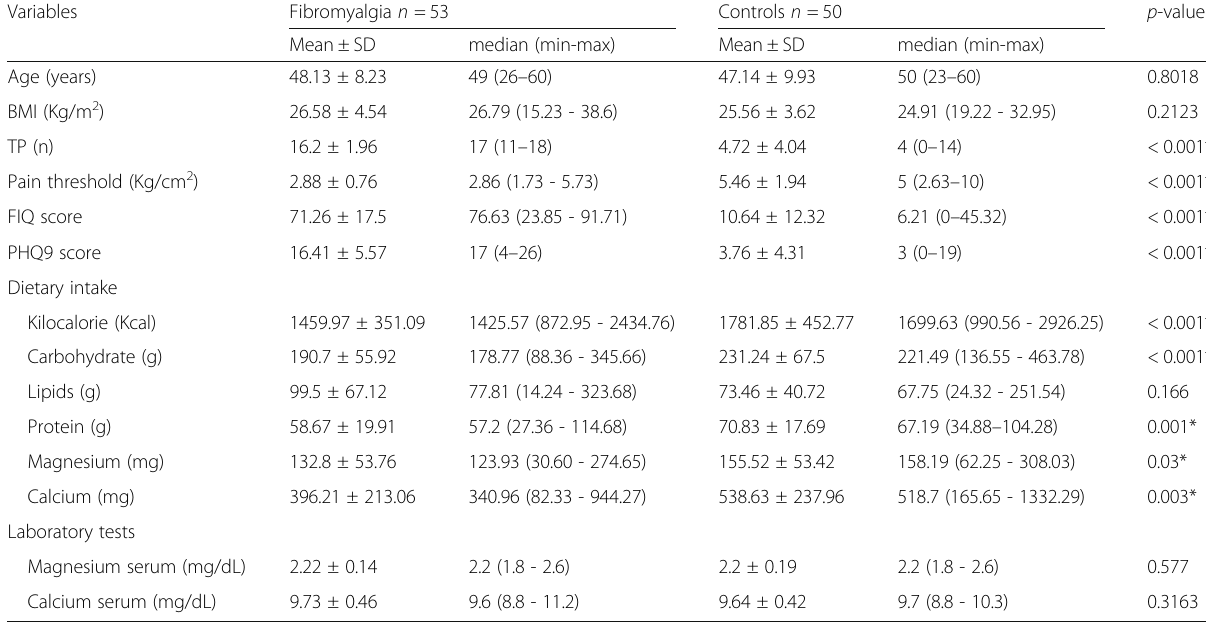
Table 1 General characteristics of the participants with fibromyalgia and controls